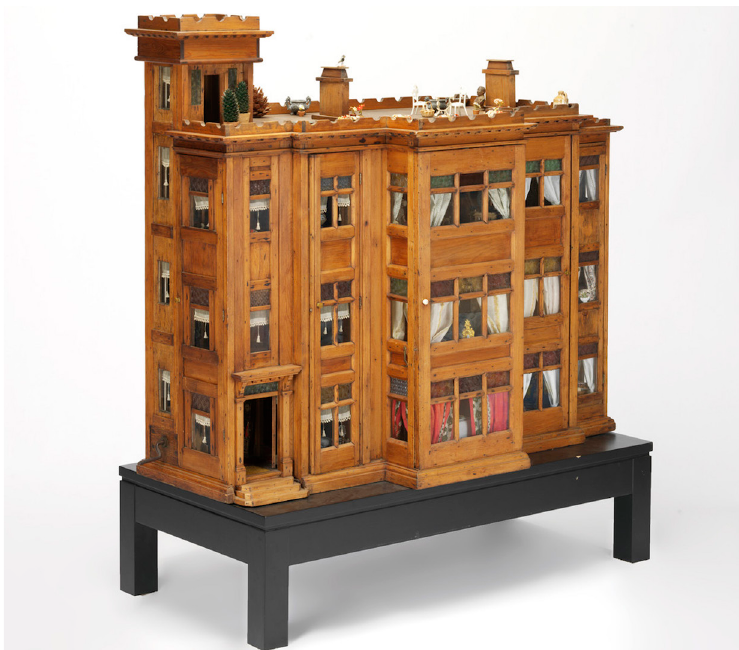
Figure 1.1 Betty Pinney’s doll’s house. Image © Victoria and Albert Museum, London